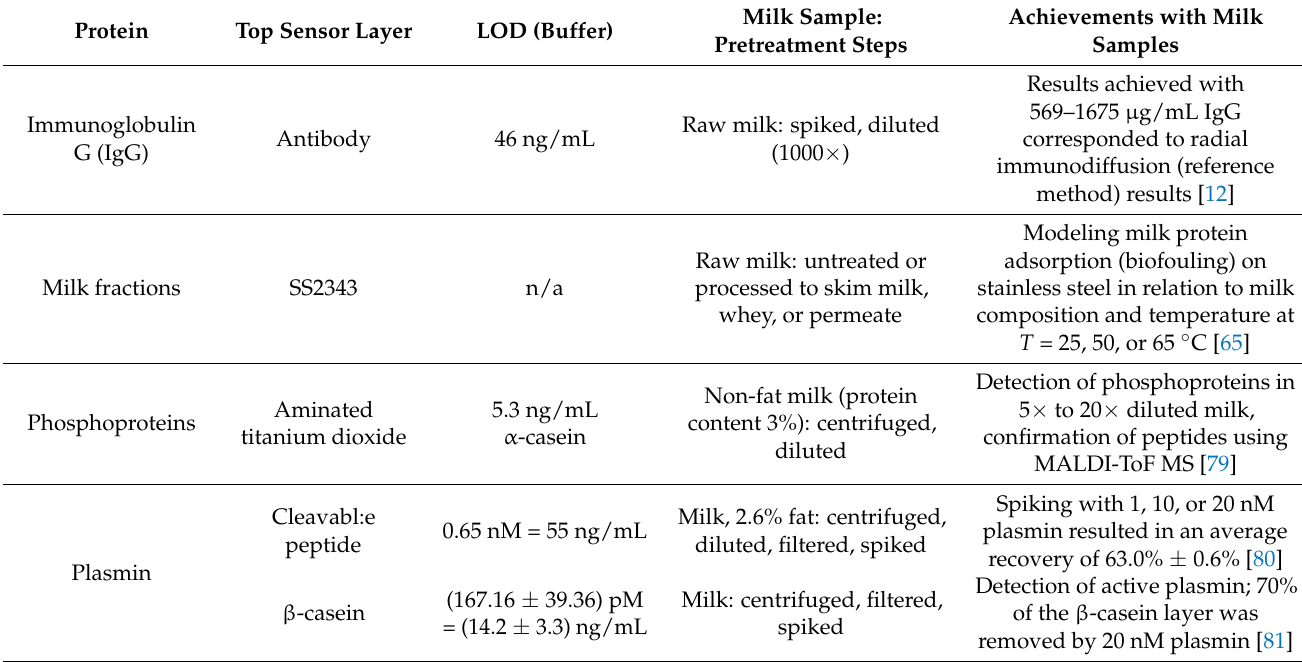
Table 1. Detection of proteins ( M r > 10,000) in cow’s milk with QCM sensors.